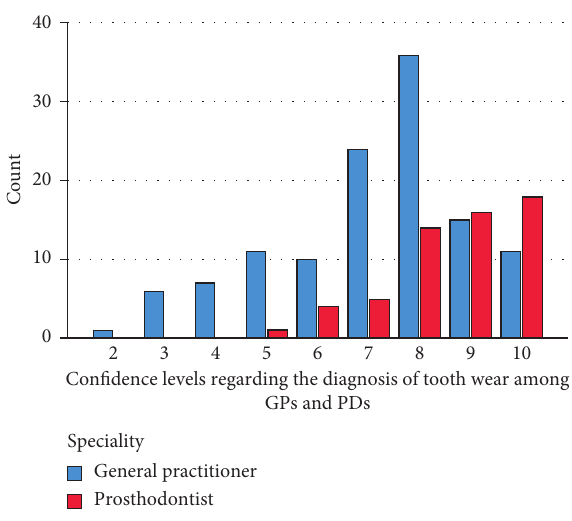
Figure 4: The frequency of confidence levels of GPs and PDs regarding the diagnosis of tooth wear on a 10-point VAS scale.